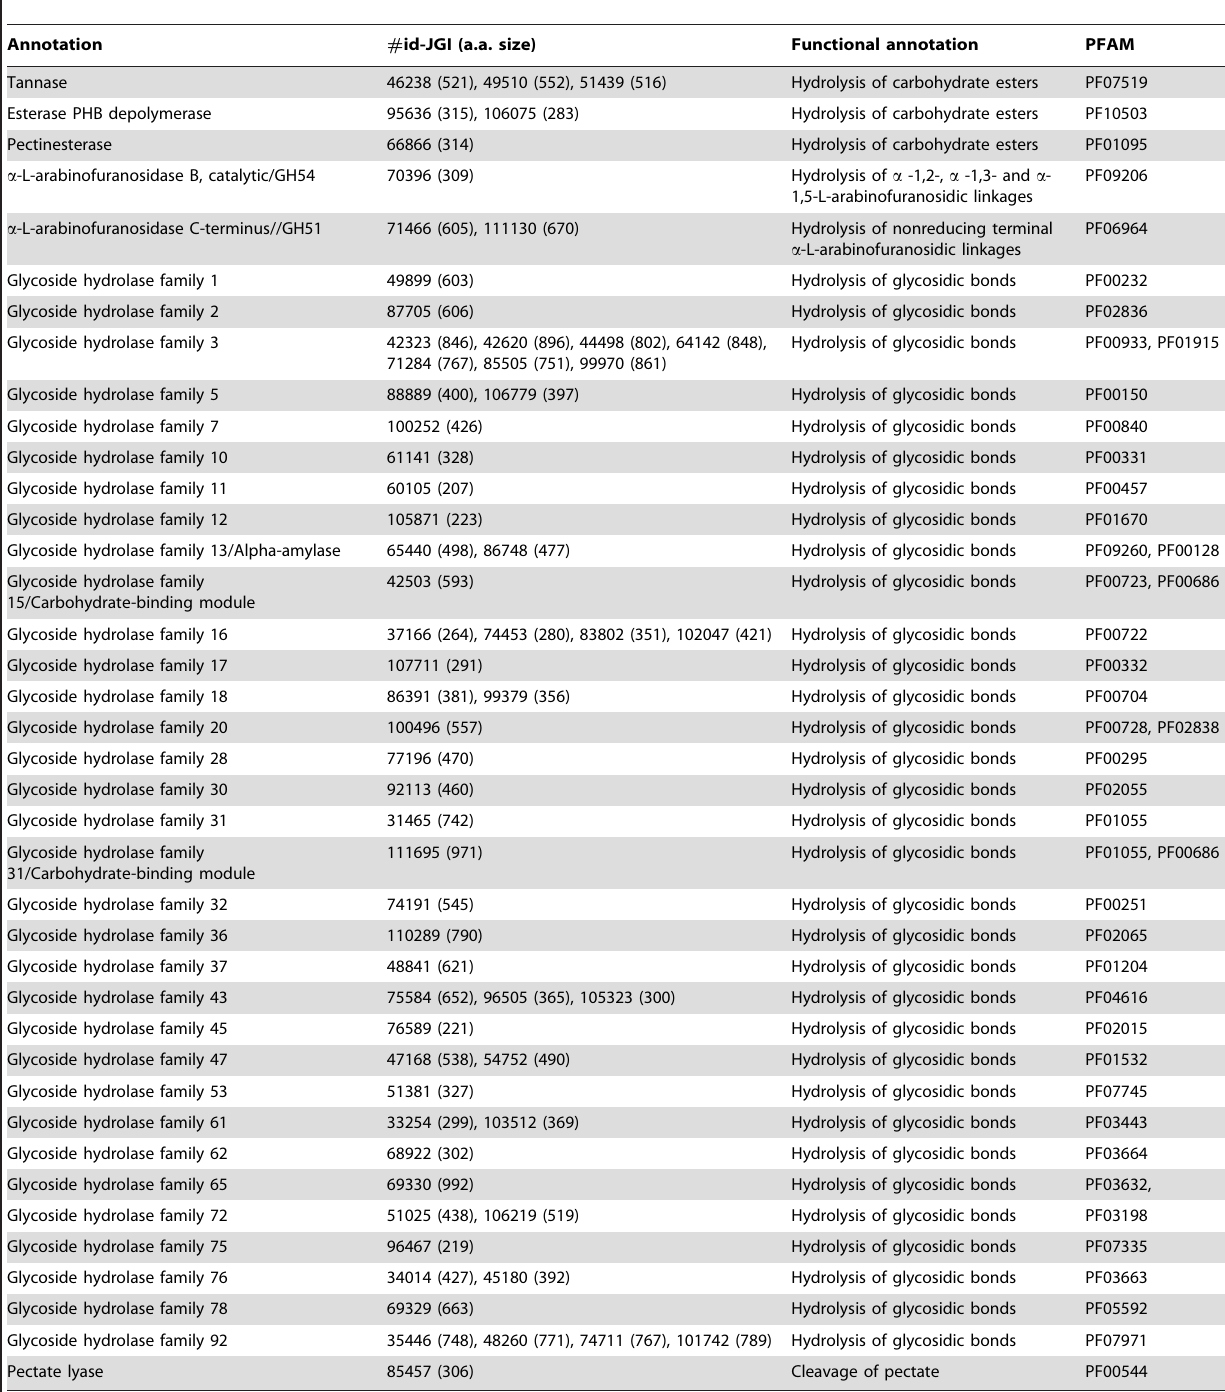
Table 2. The sub-set of M. graminicola genes that code for secreted proteins involved in the degradation of polysaccharides.